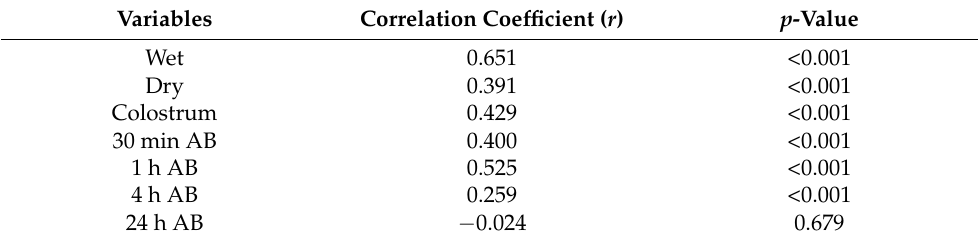
Table 16. Significant correlations between puppies’ weight and their superficial temperature at TLE thermal